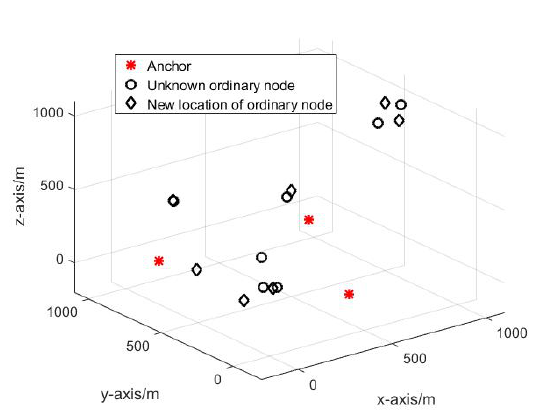
Figure 9. The topology change of DUANs.